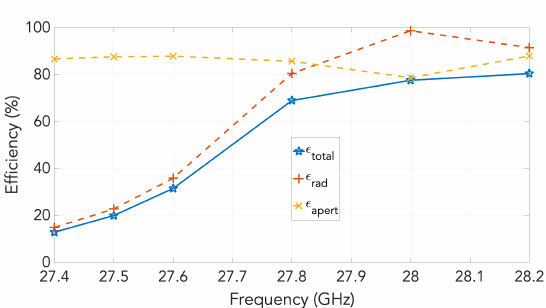
Figure 19. Aperture efficiency and radiation efficiency as a function of the frequency for the low profile horn